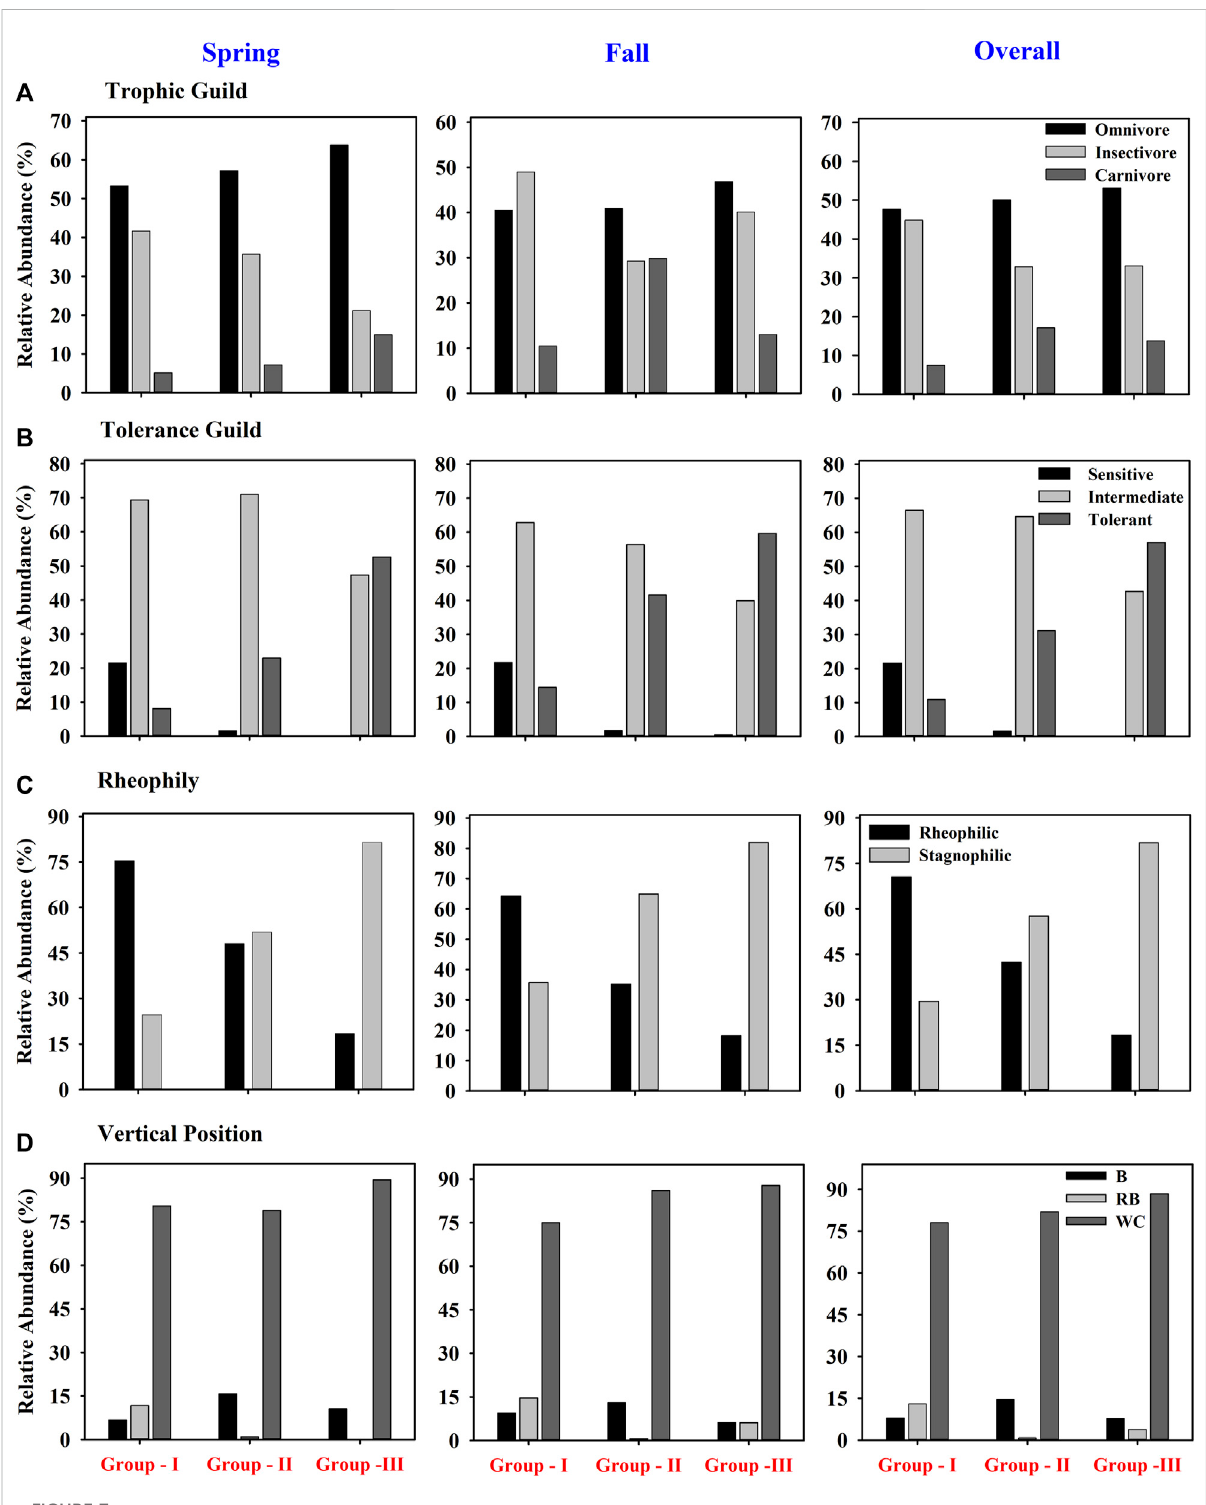
FIGURE 7 Relativeabundanceoffunctionalmetricsoftrophic (A) andtoleranceguilds (B) ,rheophily (C) andverticalpositionpreference (D) inthreespatial water quality (B-benthic; RB, rif fl e-benthic; WC, water column